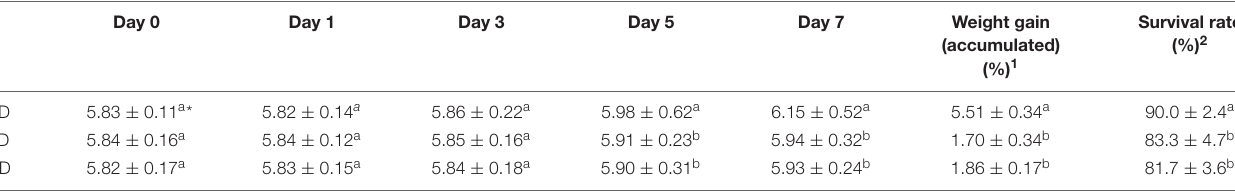
TABLE 1 | PL body weight and gains and survival rates in different groups over the 7-day test period (mg PL − 1